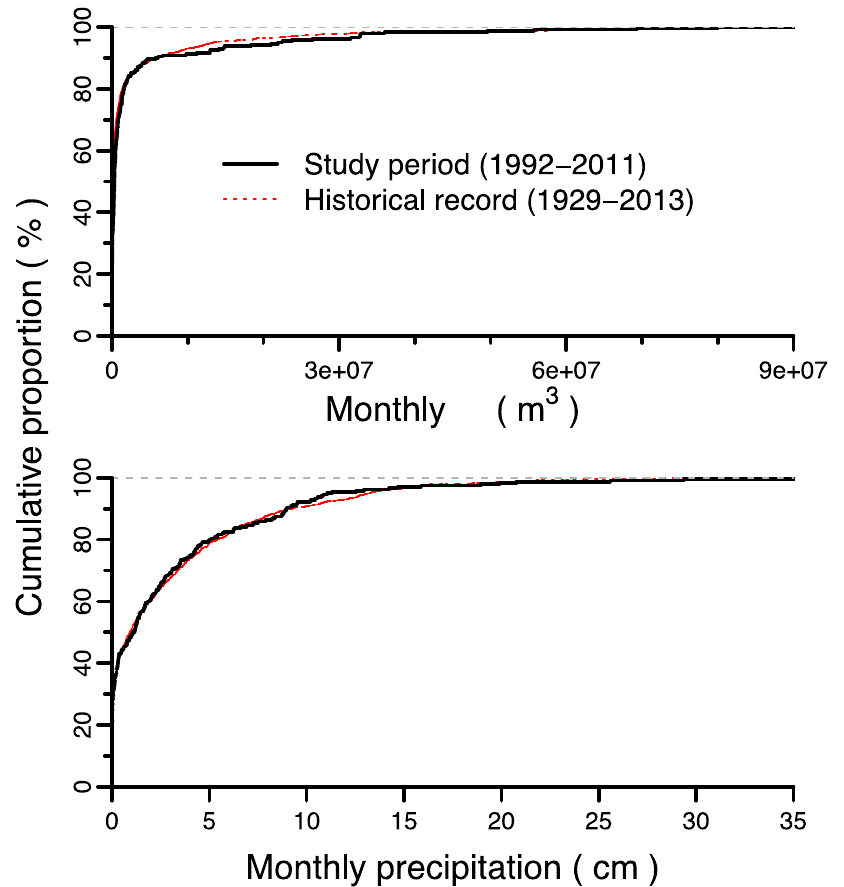
Cumulative frequency distribution curves for monthly inflow ( Q ) volume and precipitation depth.